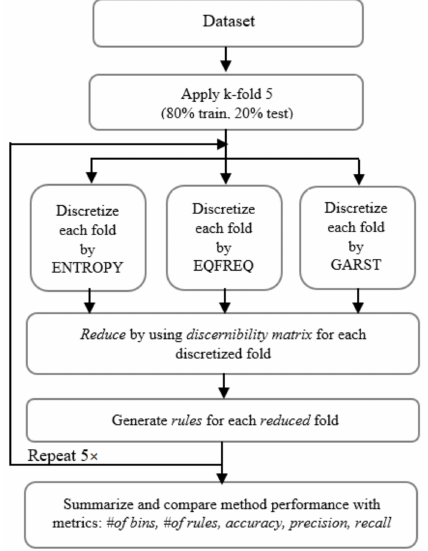
Figure 4. Flow of the research.